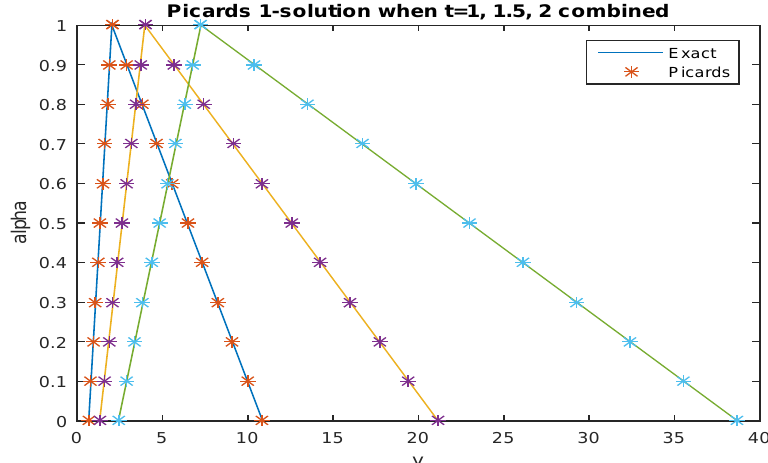
Figure 3. Exact(line) and Picard 1-solutions(stars) for t = 1.0, 1.5 and 2.0 with triangular fuzzy numbers as the initial conditions.